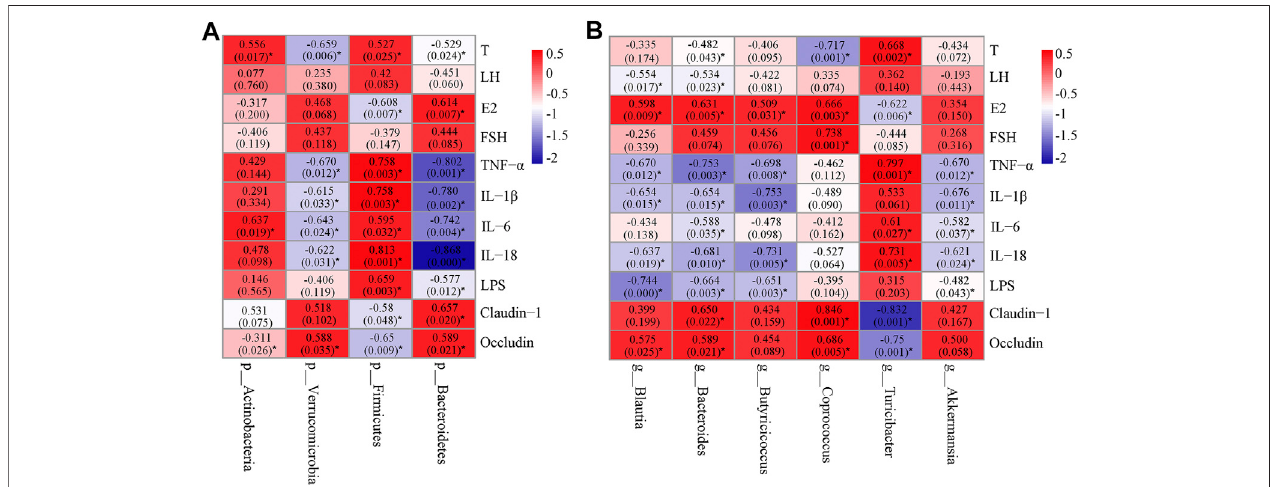
FIGURE 5 | Heatmap of Spearman ’ s correlation between the gut microbiota [at phylum level (A) and at genus level (B) ] and hormones, cytokines, LPS or tight junctionproteins.Thevalueofrrepresentsthedegreeofcorrelation(0 > r > 1,positivecorrelation; − 1 < r < 0,negativecorrelation).Signi fi cantcorrelationsweremarkedby * p <